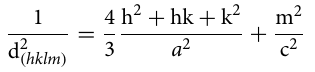
Table 1. For comparison, the lattice parameters determined from Barret 19 are also listed in Table 1. Barret’s results were determined from zone-refining Bi single crystal and are considered free from defects and strains. Our parameter a is very close to Barret’s value. However, the difference is much smaller than our standard deviation